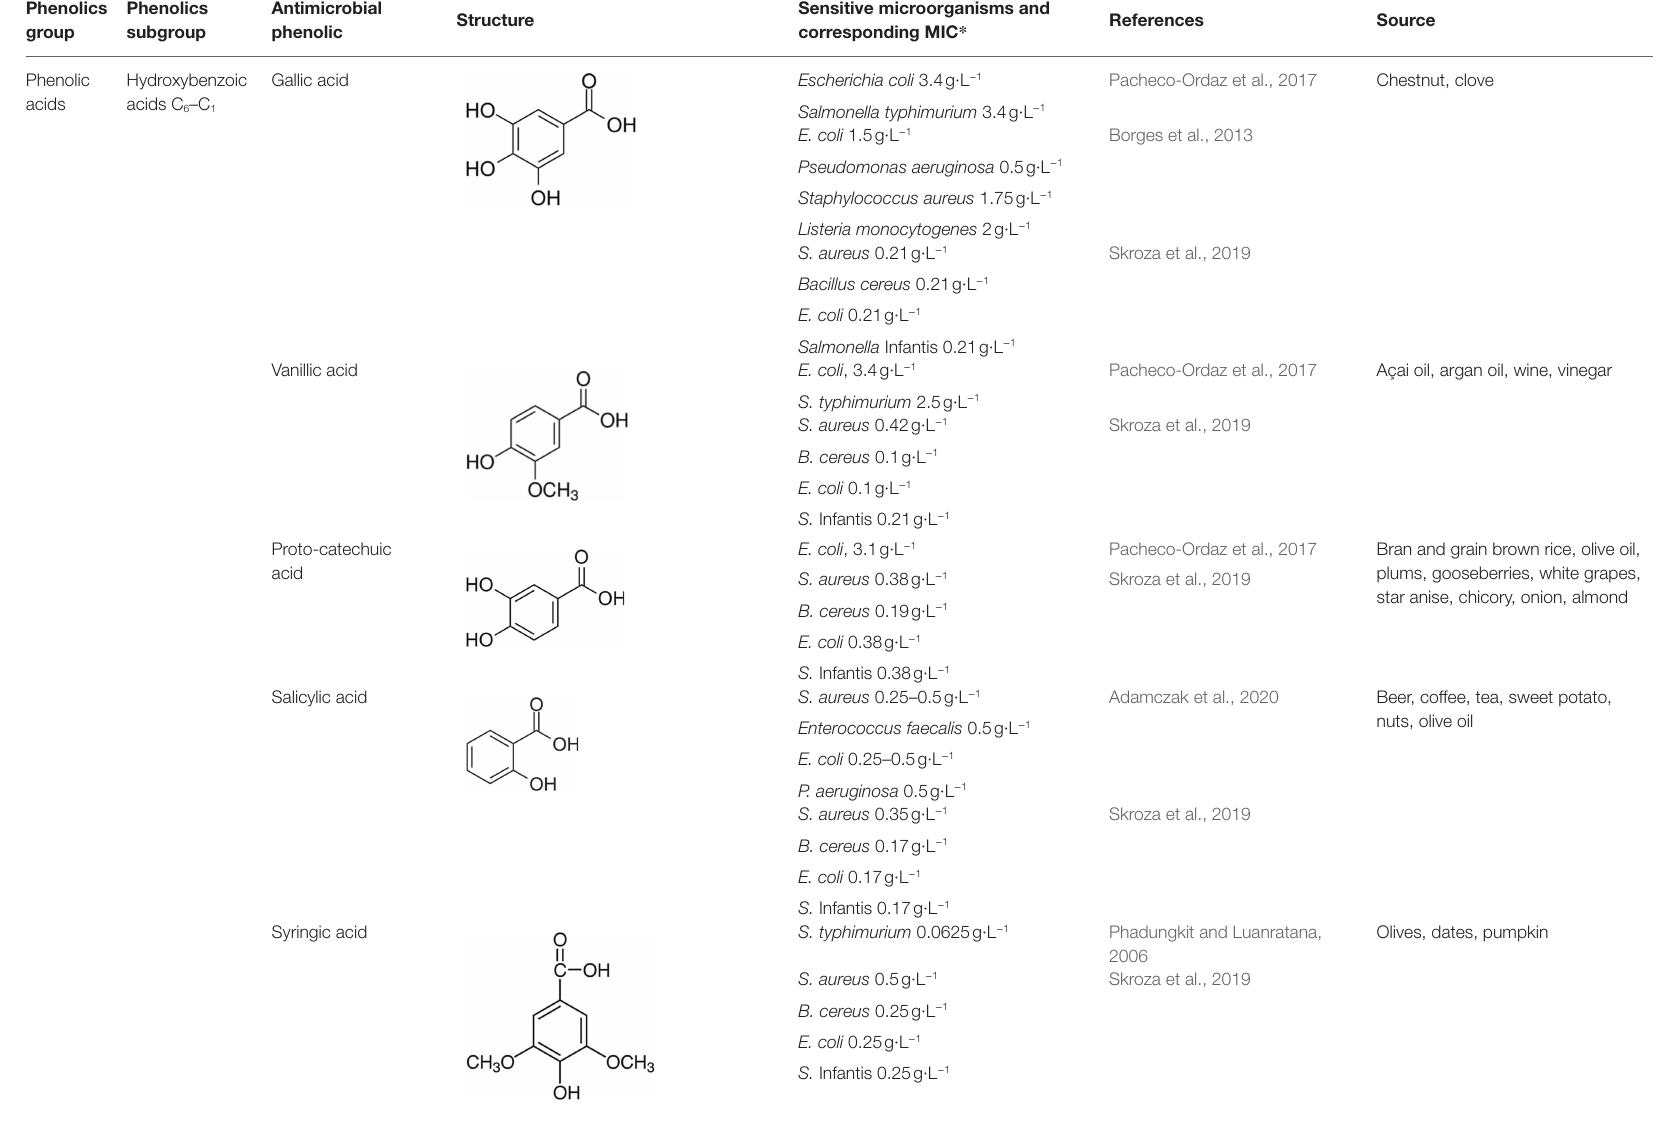
TABLE 1 | Examples of antimicrobial plant phenolics belonging to phenolic acids, flavonoids, tannins, stilbenoids, quinones, and coumarins. Phenolics Phenolics group